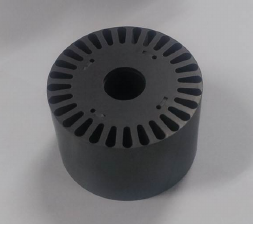
Figure 8. Core of prototype rotor (outer diameter Φ 60 × lamination 48 mm).